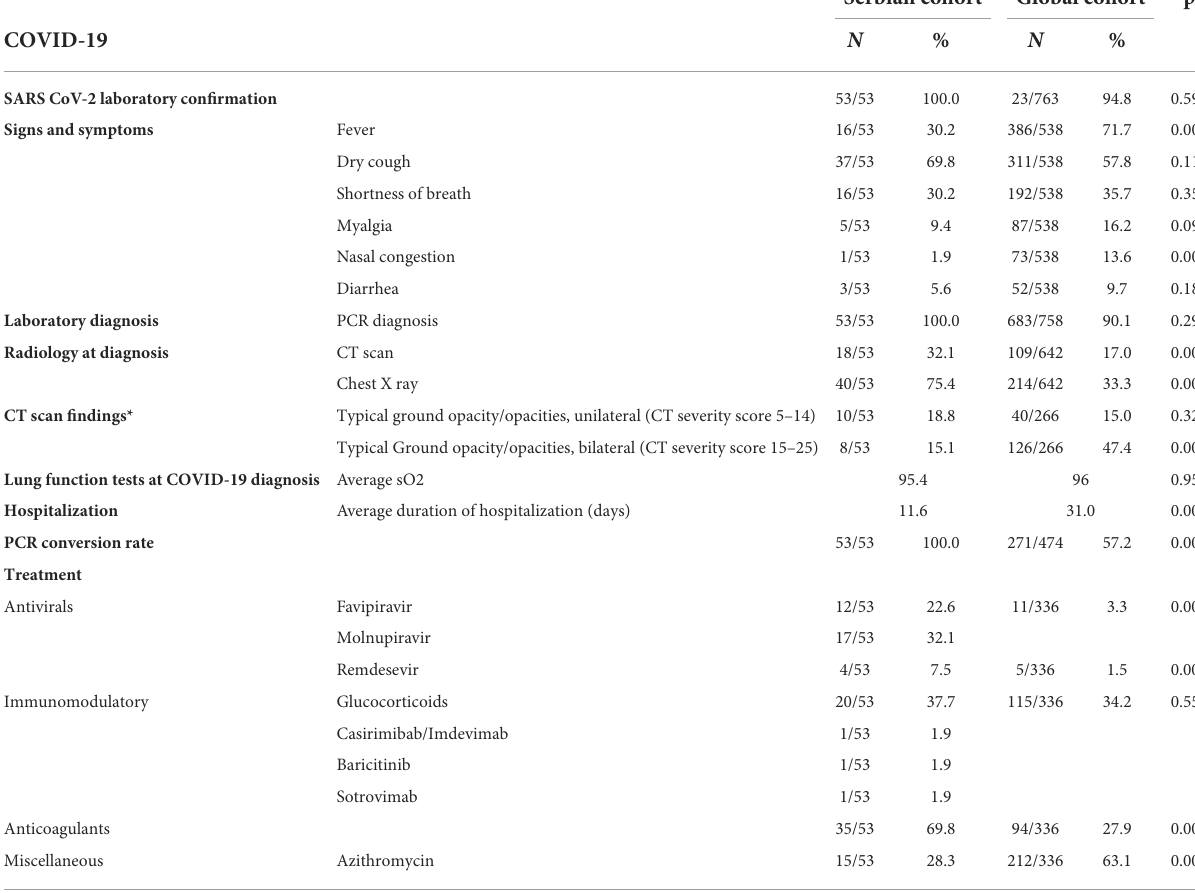
TABLE 3 Descriptive analysis of COVID-19 in the Serbian TB/COVID-19 cohort compared to the global